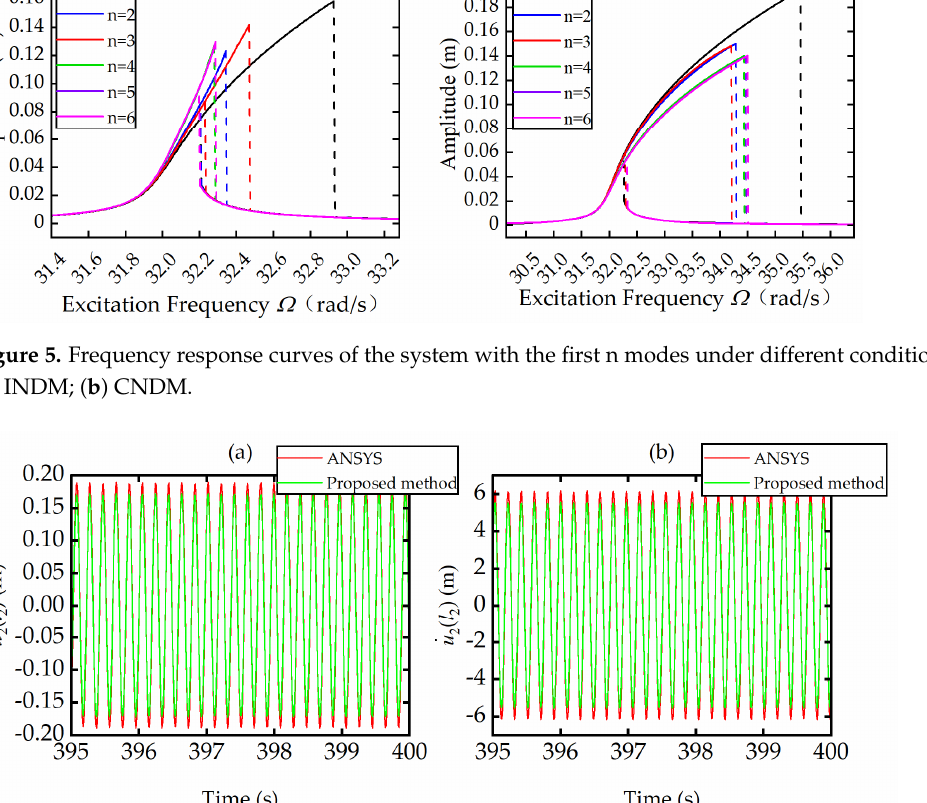
Figure 7. Amplitude response curves of the INDM ( a ) and the CNDM ( b ) with the first n modes. The influences of excitation amplitudes on the responses of the nonlinear system for the INDM and the CNDM are shown in Figure 8a,b respectively. The curves show that the responses are positively correlated with the excitation amplitude in both systems. It can also be seen that there is a jump phenomenon in the nonlinear response. The greater the excitation, the more obvious the jump, and the higher the corresponding jump fre- quency.